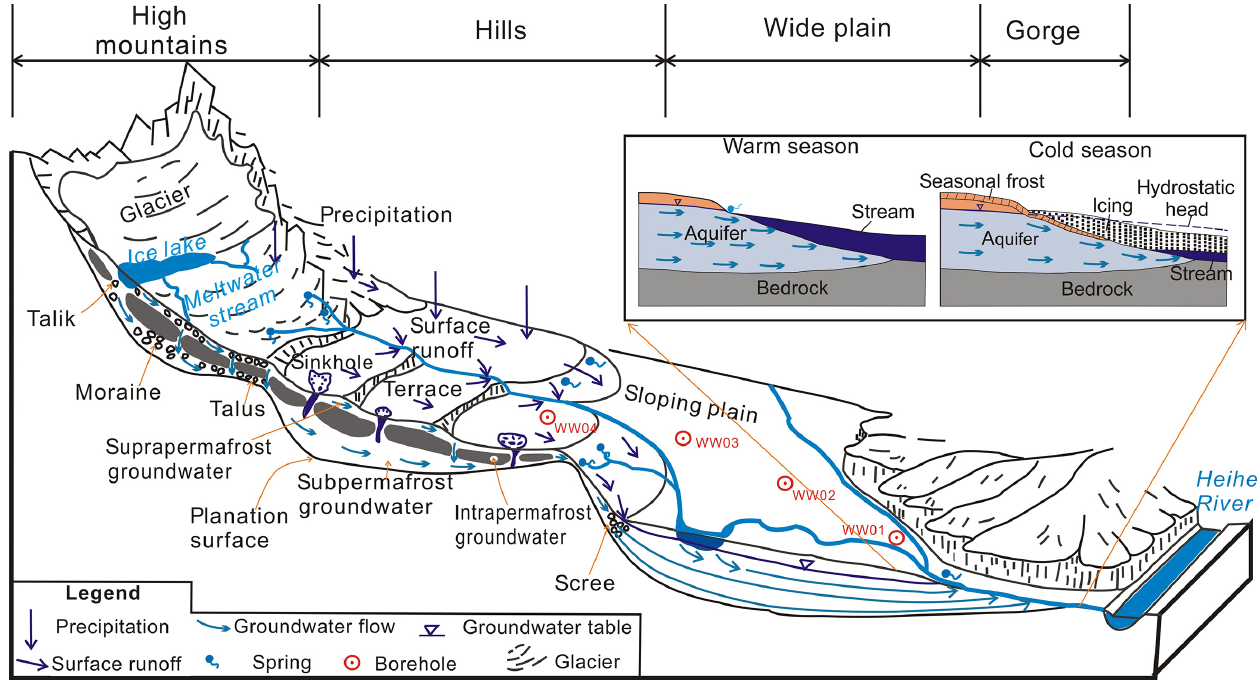
Figure 12. Conceptual model of groundwater exchange and pathways in the Hulugou